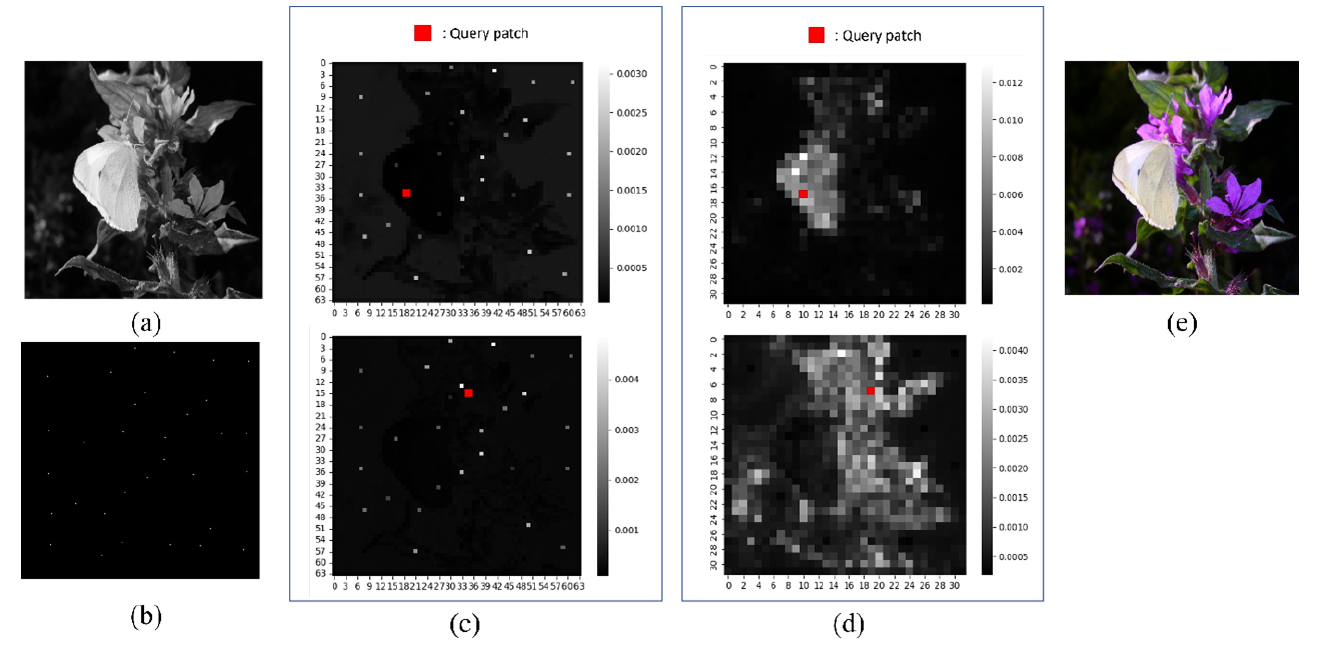
Figure 3. Visualization of the attention map in the transformer layer. ( a ) Input luminance. ( b ) Input color hint mask. ( c ) Self-attention map in the first transformer block of the encoder. ( d ) Self-attention map in the second transformer block of the encoder. ( e ) Ground-truth color image. Note that the attention maps in ( c , d ) are produced with each query patch,